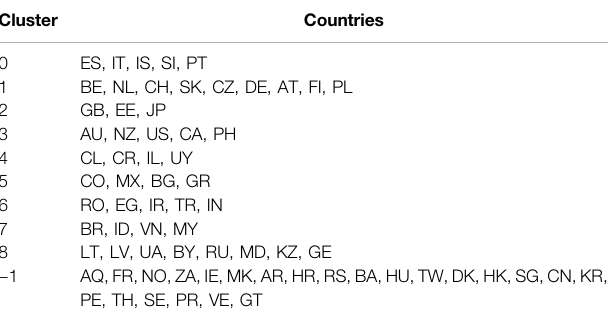
TABLE1| CountryclustersasdeterminedbyOPTICSwithaminimumclustersize of 3, based on the output of a t-SNE visualization (perplexity of 5) on PCA- reduced country feature vectors (100